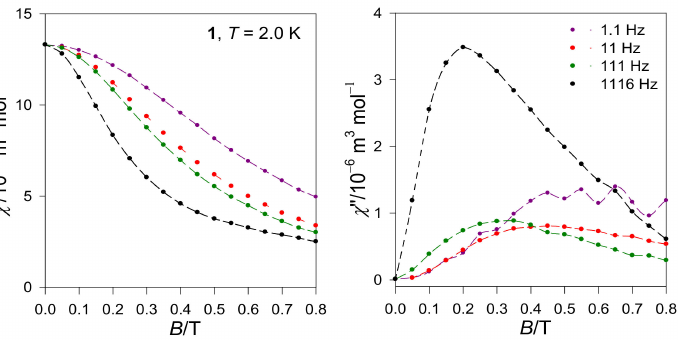
Figure 5. AC susceptibility data for 1 : field dependence for a representative set of frequencies at T = 2.0 K. Lines are visual guide.